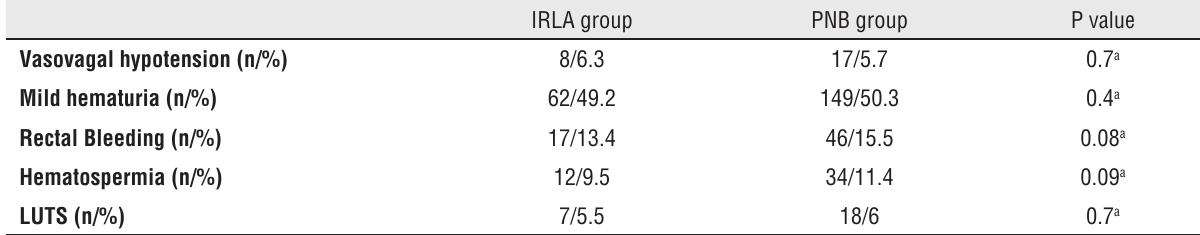
Table 2 - comparison of the minor complications after the procedure in IRLA and pnB